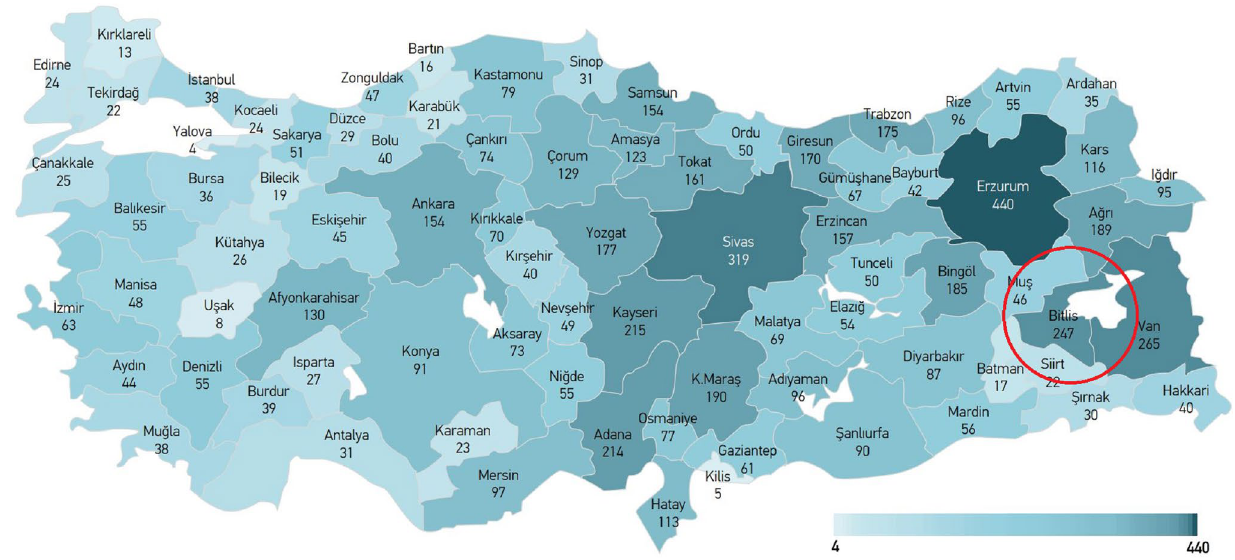
Fig. 1 The number of flood events in Turkey between 1950 and 2019 (AFAD,